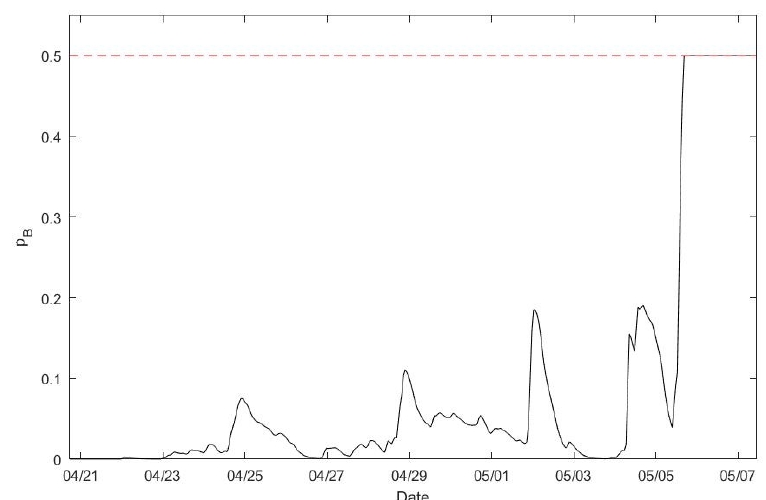
Figure 10. Model predicted burial percentage p B ( t ) with re-exposure parameterization (13) for each object at the shallow quadpod from 20 April to 7 May 2013. The predicted burial percentage p B ( t ) is less than 0.5 for all the munitions during the whole time period, except during the storm event from 12:00 5 May to 00:00 6 May 2013. The burial percentage p B ( t ) is the same for each object, since it only depends on the sediment characteristics [see Equations (9)–(11)].